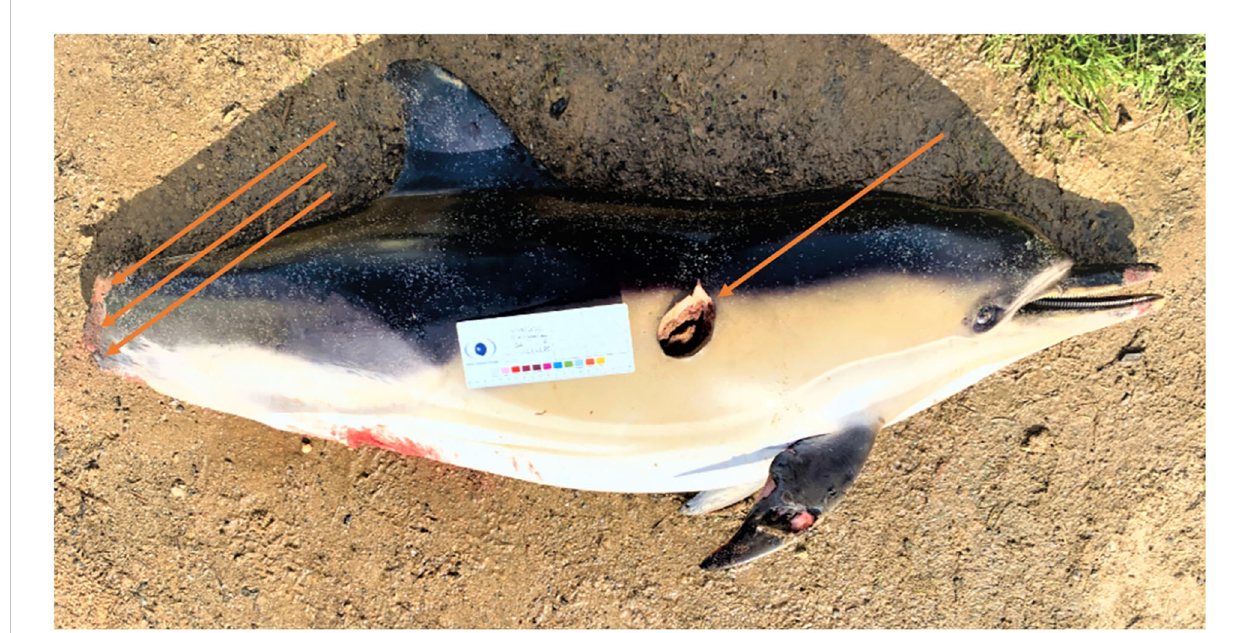
FIGURE 6 Amputations of appendages and perforations carried out during stripping operations – Common dolphin, March 2022, Bretignolles-Sur-Mer (85), ©